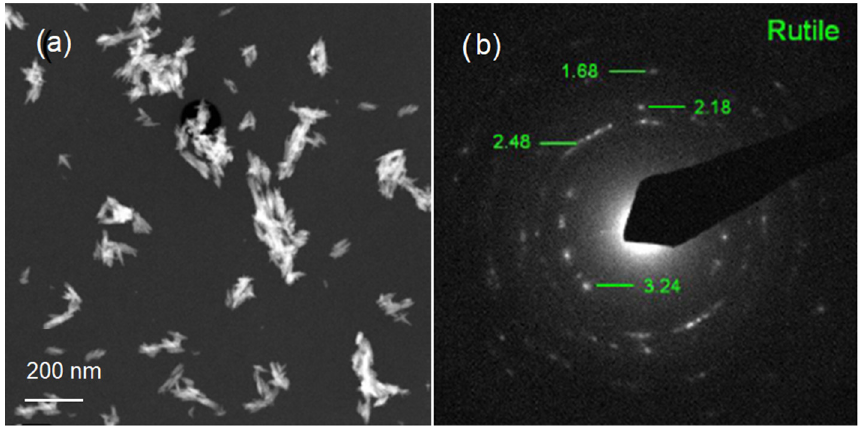
Figure 2. Images of the rutile phase: ( a ) TEM image of nano-TiO 2 powder; ( b ) TEM image of nano-TiO 2 .